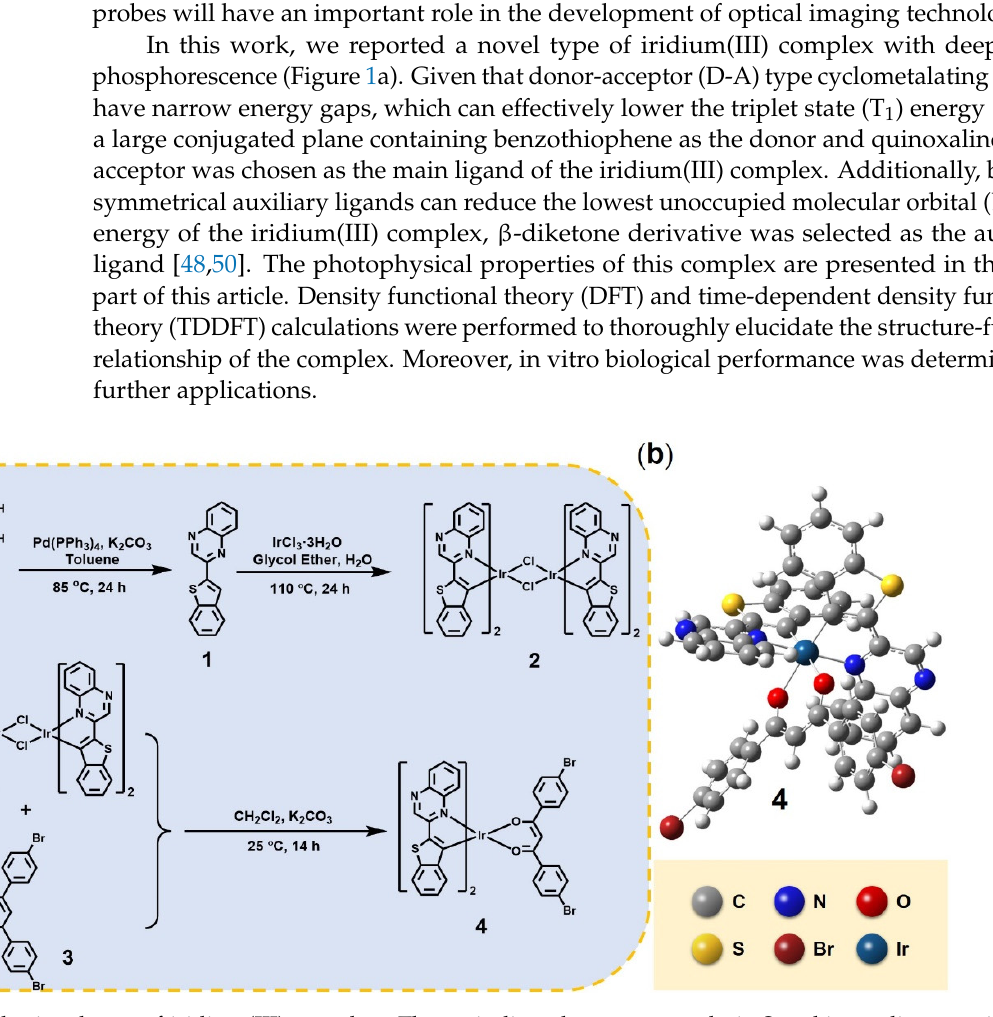
Figure 1. ( a ) Synthesis scheme of iridium(III) complex. The main ligand was prepared via Suzuki coupling reaction. Complex 4 was synthesized according to the typical two-step method for neutral iridium(III) complex (the cyclometalated iridium (III)-chlorobridged dimers were prepared by refluxing iridium trichloride with the main ligand, which was treated with the auxiliary ligand to obtain the final product). ( b ) The ground state geometric structure of complex 4 based on the B3LYP/LANL2DZ